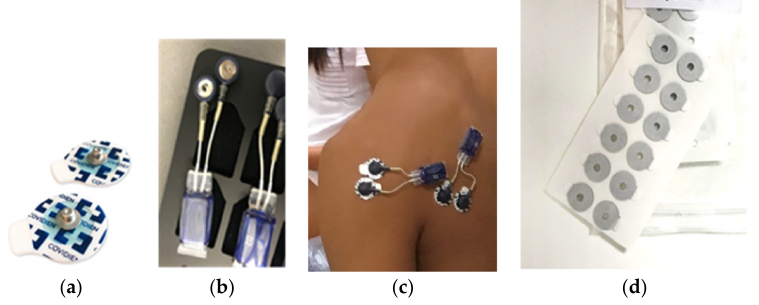
Figure 2. Electrode attachment: ( a ) wireless EMG electrodes; ( b ) rubber gaskets; ( c ) clips with pre-gelled surfaces; ( d ) double-sided